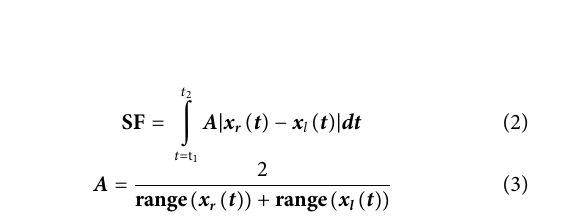
Where x r ( t ) was de fi ned as the value of the parameter recorded for the right knee at the time t. x l ( t ) was de fi ned as the value of the parameter recorded for the left knee at the time t SF is the